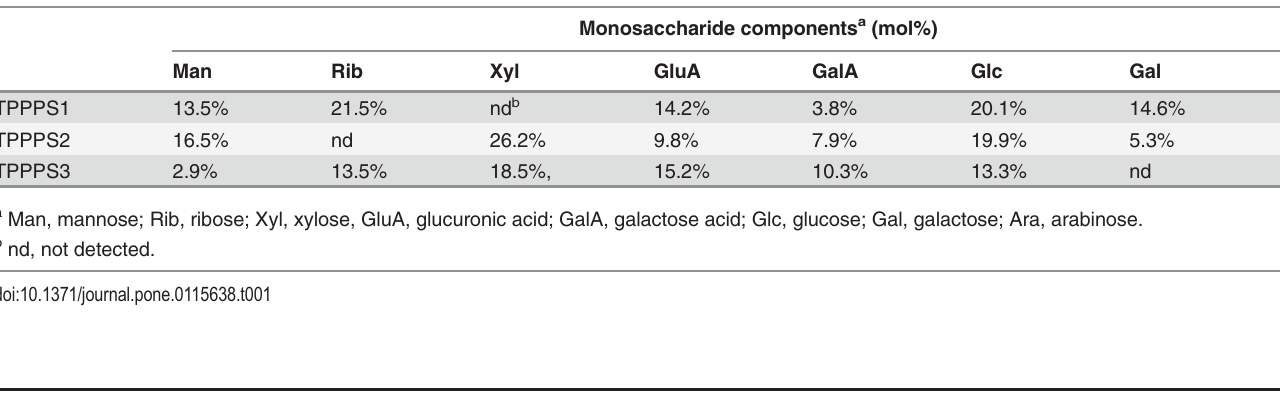
Table 1. Components of monosaccharide from